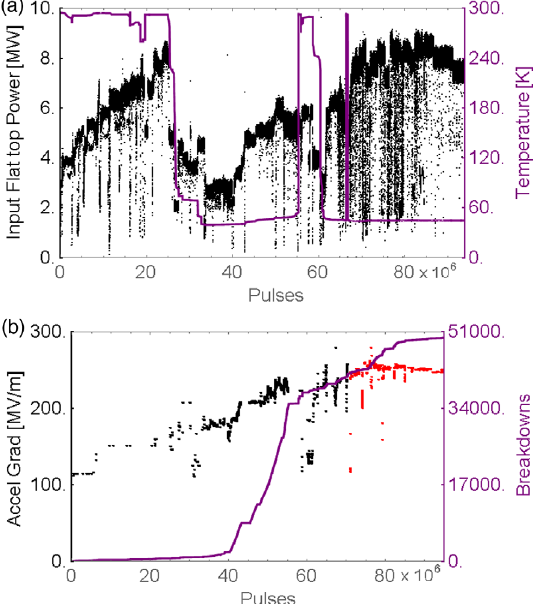
FIG. 9. The processing history for Cryo-Cu-SLAC-#2. (a): Black is the input flat steady-state power (average between t 1 and t 2 as defined in Fig. 6) and purple is the temperature. (b): Purple is the number of accumulated breakdowns. Black and red points are the calculated average gradient (average between t 1 to t 2 ). Red indicates the time period where BDR was measued and a zoom-in is shown in Fig. 10.